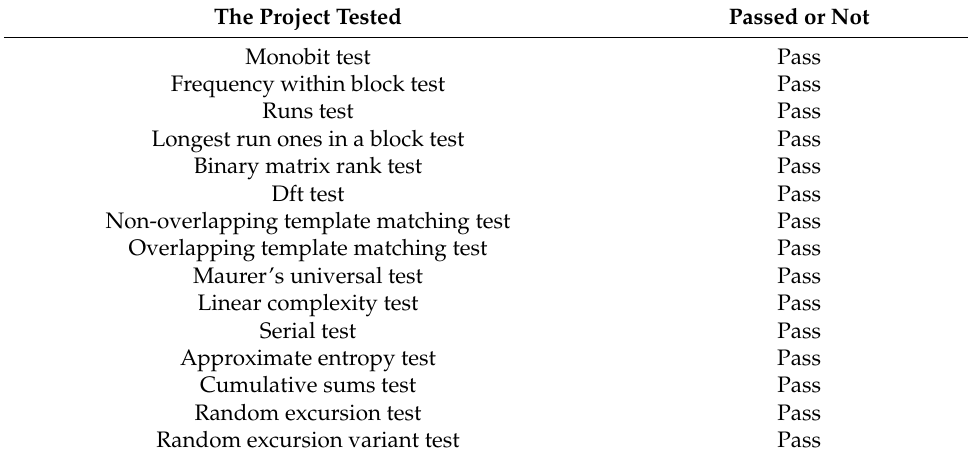
Table 1. NIST statistical test